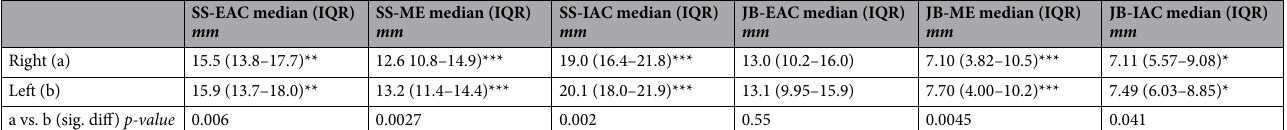
Table 2. Average distances of the sigmoid sinus and jugular bulb from selected ear region (external acoustic canal, middle-ear & internal acoustic canal) according to side differences. mm millimeters, IQR Interquartile range, SS sigmoid sinus, JB jugular bulb, EAC internal acoustic canal, ME middle-ear, IAC internal acoustic canal. Wilcoxon rank test showing *Significant different with p < 0.05; **Significant different with p < 0.01; ***Significant different with p < 0.005.